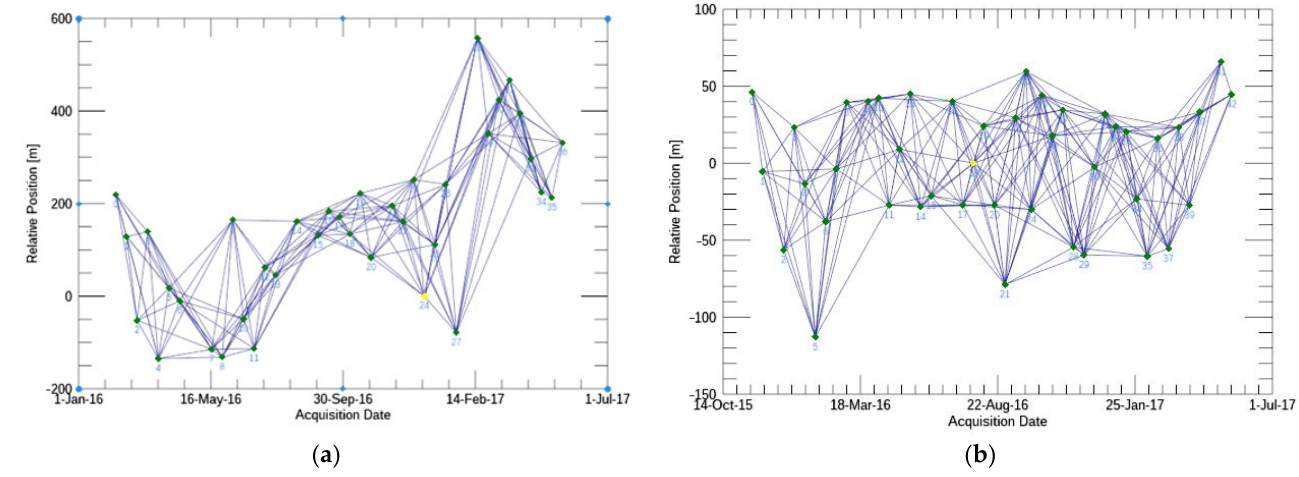
Figure 5. Interferometric pairs selected (solid blue lines): ( a ) TSX pairs, ( b ) S1B pairs. Yellow dot means reference image.